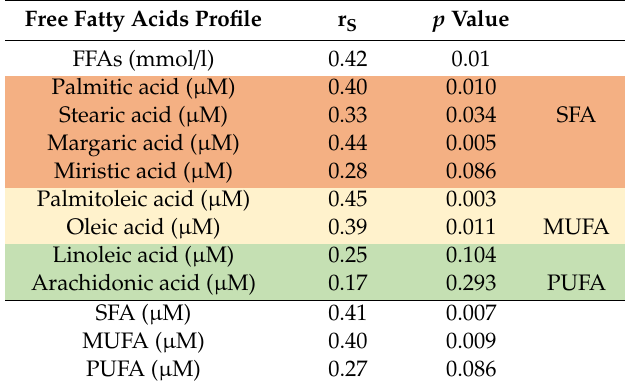
Abbreviations: free fatty acids (FFAs), monounsaturated fatty acids (MUFA), polyunsaturated fatty acids (PUFA), saturated fatty acids (SFA).